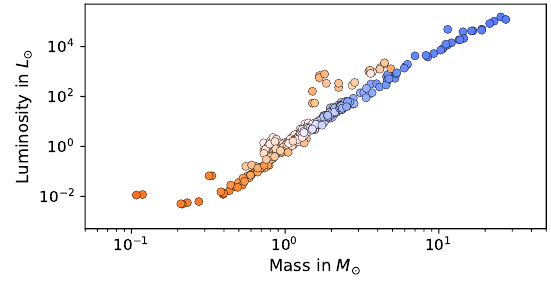
Fig. 31.— Mass-luminosity diagram with data points plotted in the color corresponding to a star’s temperature. Data from DEBCat color maps are available for the purpose. In Fig. 32, the color now indicates the radius of each star, with the scale shown by the colorbar on the right. Clearly, stellar radii